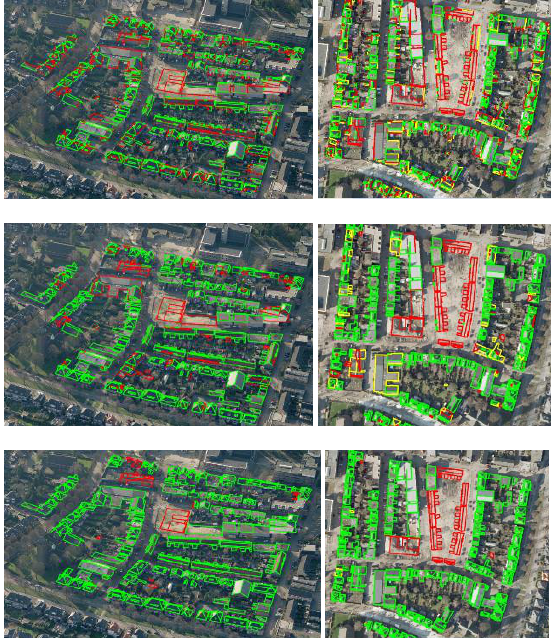
Figure 8. Verification results using oblique ©Blom (left) and nadir images (right) - per edge (top), per roof face (middle) and per building (bottom) – the green are existing, red are demolished and yellow are demolished but wrongly identified